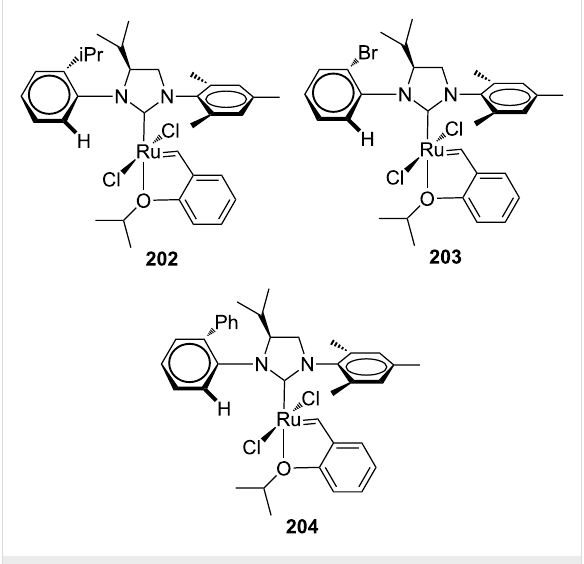
Figure 37: Backbone-monosubstituted catalysts 202 – 204 .